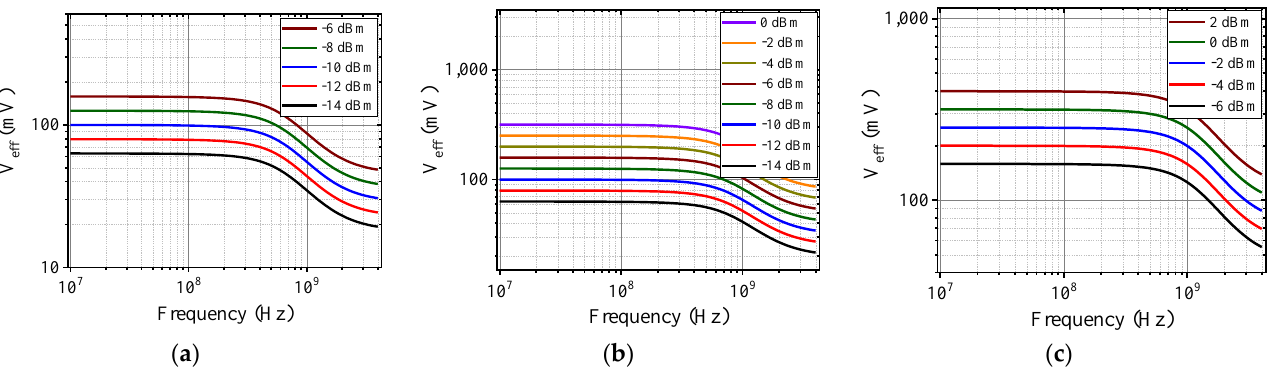
Figure 11. Calculated Veff for PMOS in the inverter ( a ) 65nm, ( b ) 130 nm, and ( c ) 180 nm technology node.